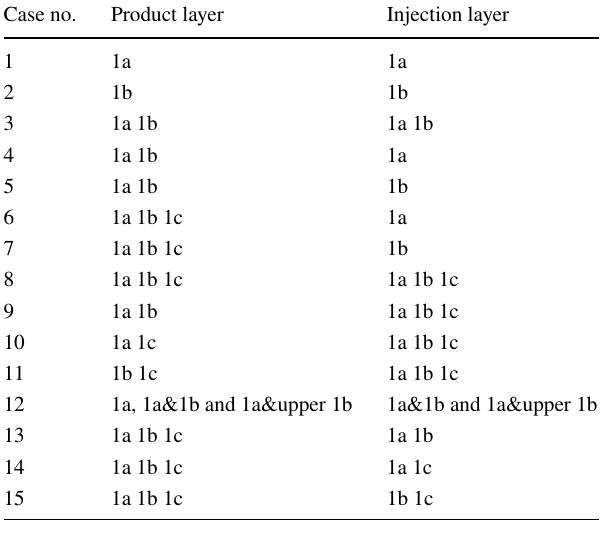
Table 14 Product layer and injection layer optimization cases Case no.